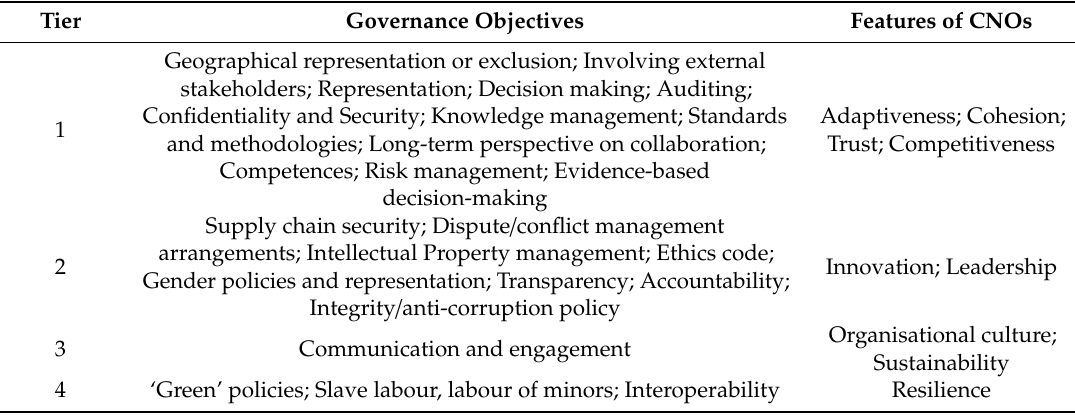
Table 2. Prioritisation of governance needs, objectives, and